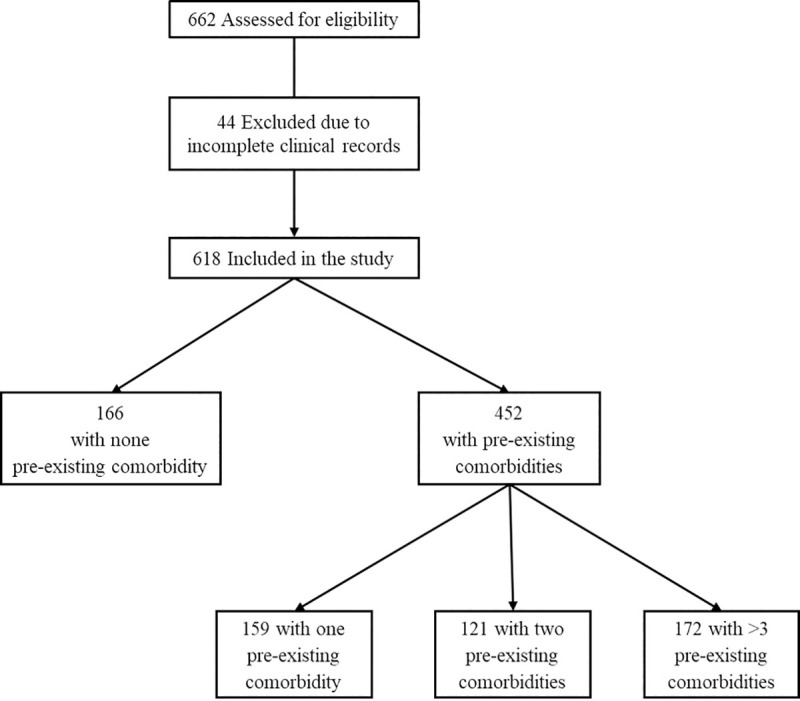
Flow-chart of the study.